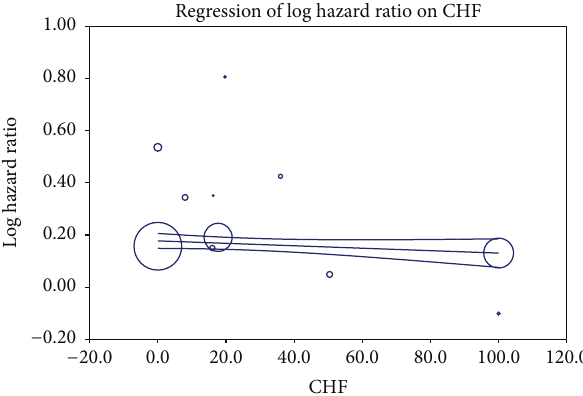
Figure 4: Effect of percentage of patients with CHF in individual studies on mortality risk of digoxin using a multivariate metaregres- sion model; increased percentage of patients with CHF on the 𝑥 -axis correlates with decreased HR on the 𝑦 -axis.